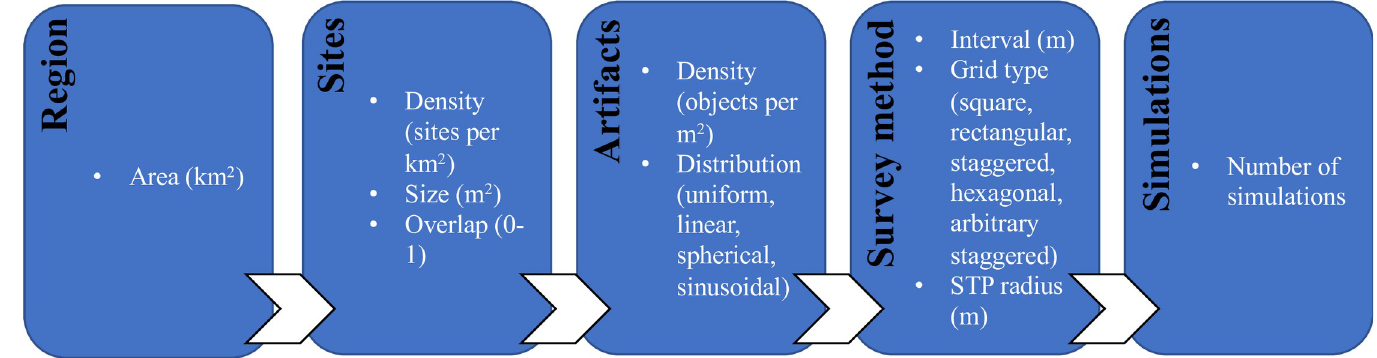
Fig 1. Schematic of DIGSS user-specified